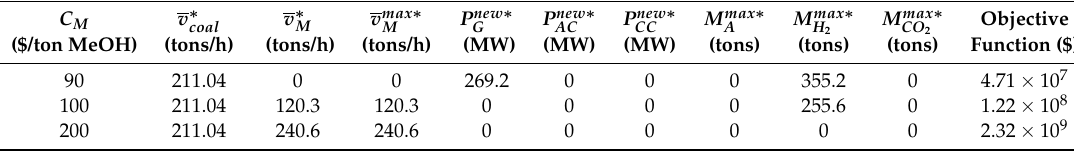
Table 7. Optimal design results as a function of methanol